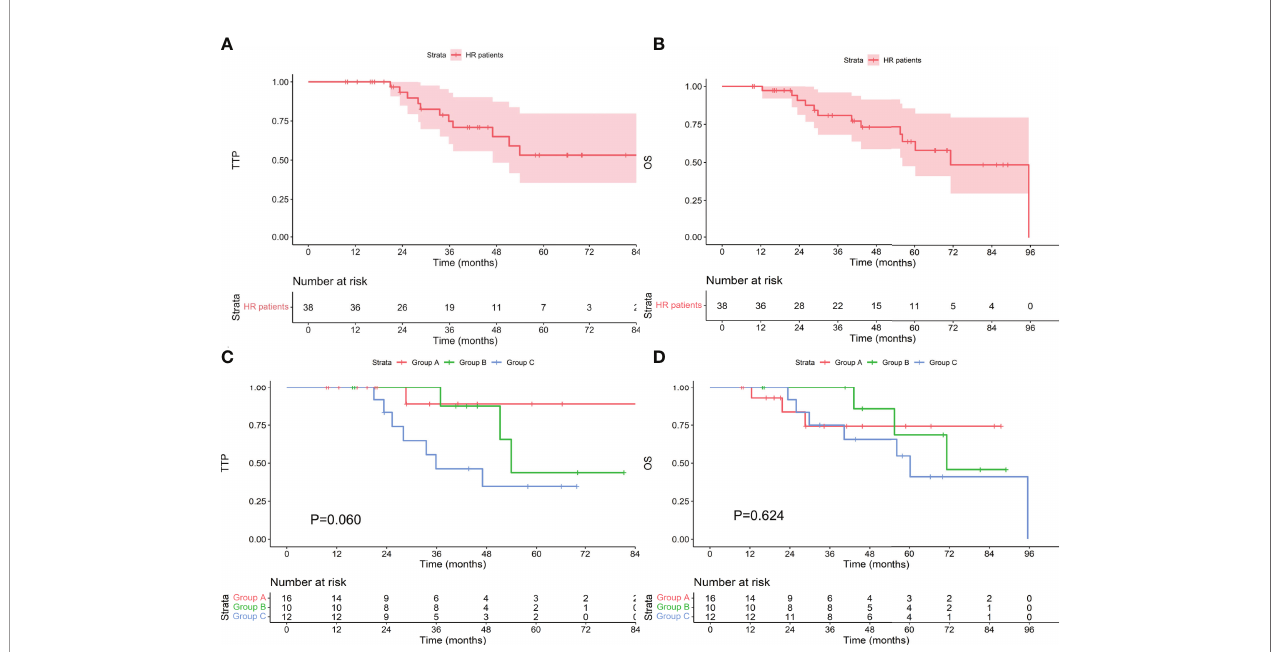
FIGURE 4 | TTP (A) and OS (B) for patients with high-risk cytogenetics and TTP (C) and OS (D) for patients who achieved an MRD-negative status at different stages. HR, high-risk